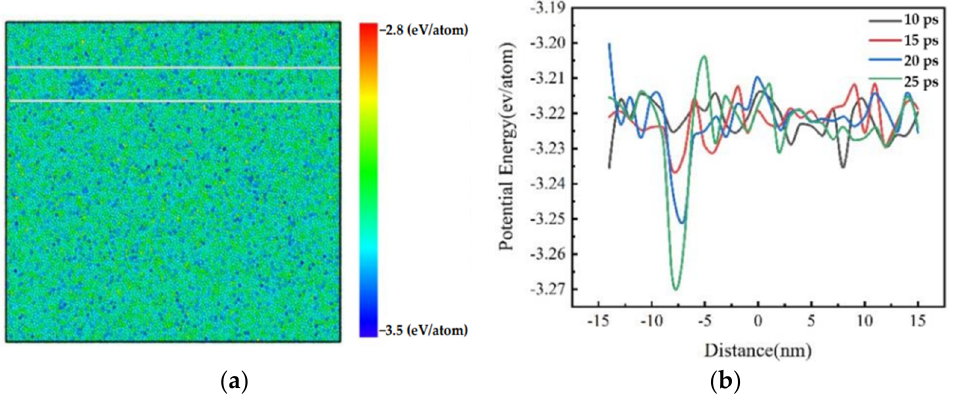
Figure 3. Potential energy of Al melt at a cooling rate of 2.0 × 10 11 K/s for 25 ps. ( a ) Potential energy map; ( b ) potential energy change diagram.